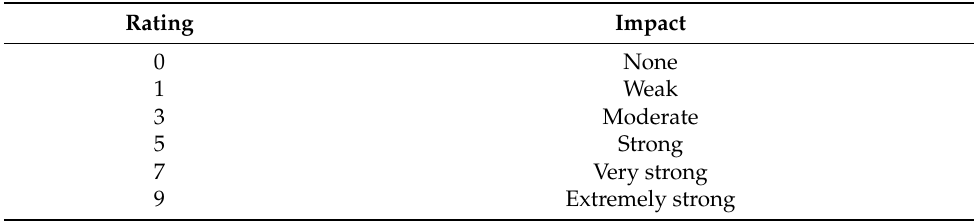
Table 5. Importance ratings scale